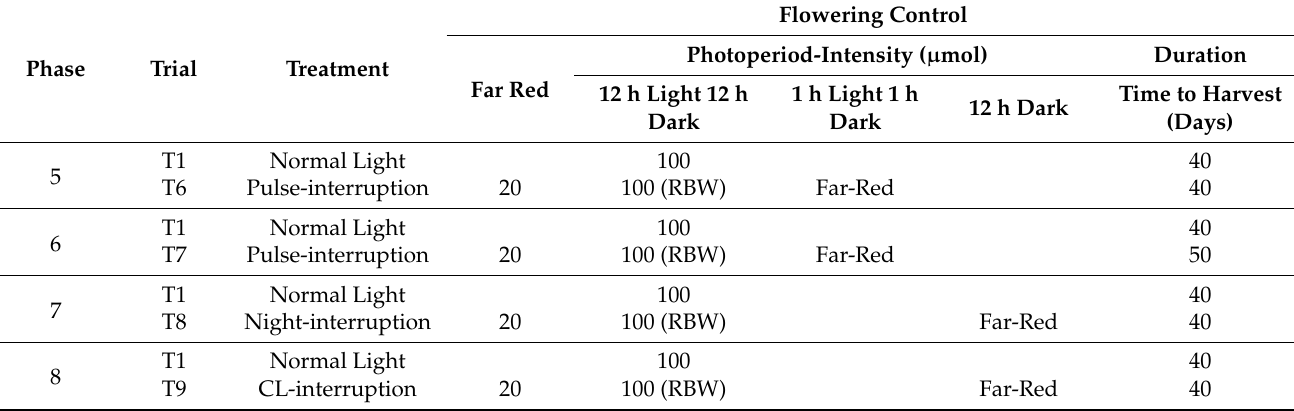
Table 4. The LED parameters for flowering control experiment (part 2).